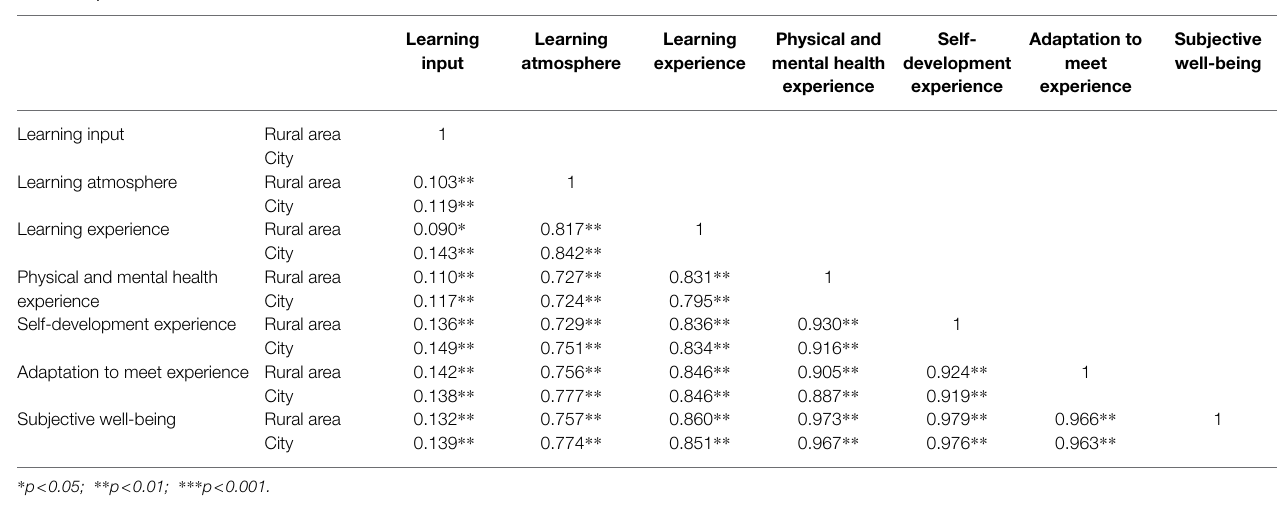
TABLE 7 | Correlation between